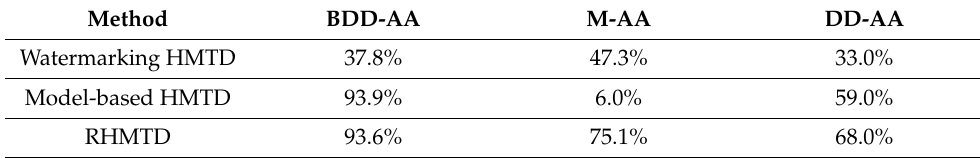
Table 4. ADP of existing HMTD methods and RHMTD against three alert attackers.